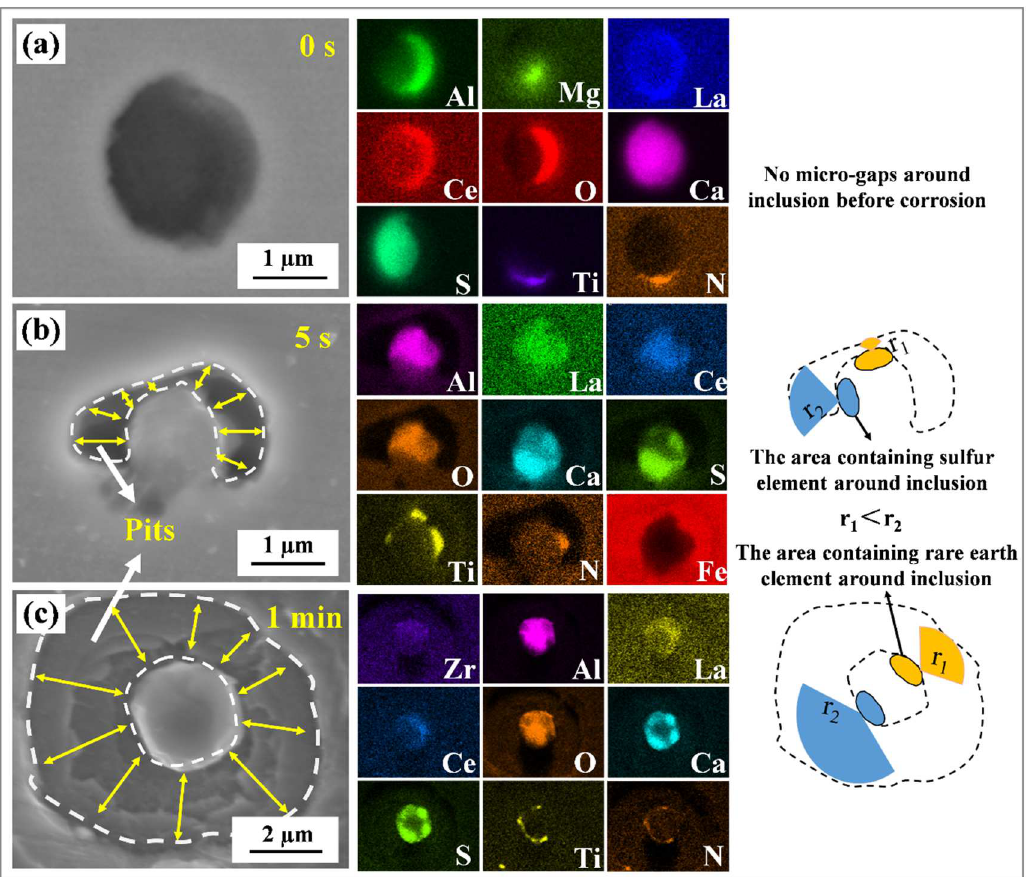
Figure 8. SEM images and EDS results of the immersion test. ( a ) Immersion for 0 s, ( b ) immersion for 5 s and ( c ) immersion for 1 min.